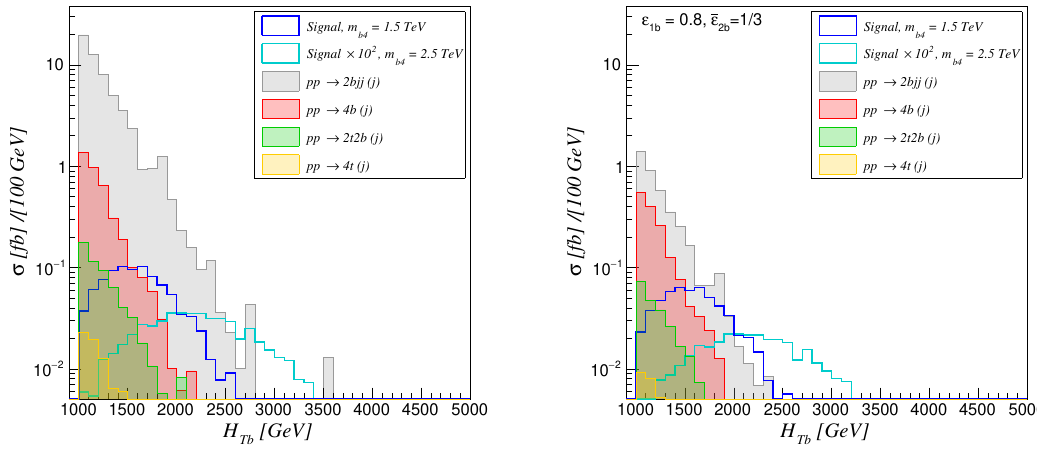
Figure 5 . Left: H Tb distribution for the 6 b signal and backgrounds in the 4b analysis. We show the signal distribution for m b = 1 : 5 and 2.5 TeV in blue and cyan respectively. The gray, red, 4 green, and yellow shaded regions show the H Tb distributions of the 2 bjj ( j ) 4 b ( j ), 2 t 2 b ( j ), and 4 t ( j ) backgrounds respectively. Right: H Tb distribution for the 6 b signal and backgrounds